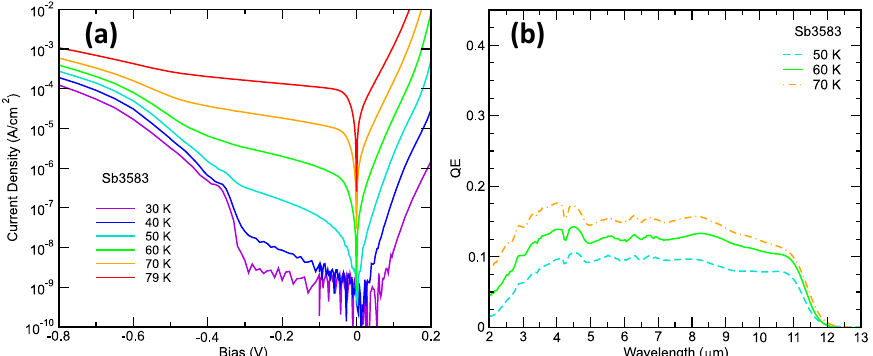
Figure 5. ( a ) Dark current density as a function of applied bias, measured at several temperatures, and ( b ) backside illuminated spectral QE, for an n-CBIRD detector fabricated from sample Sb3583.